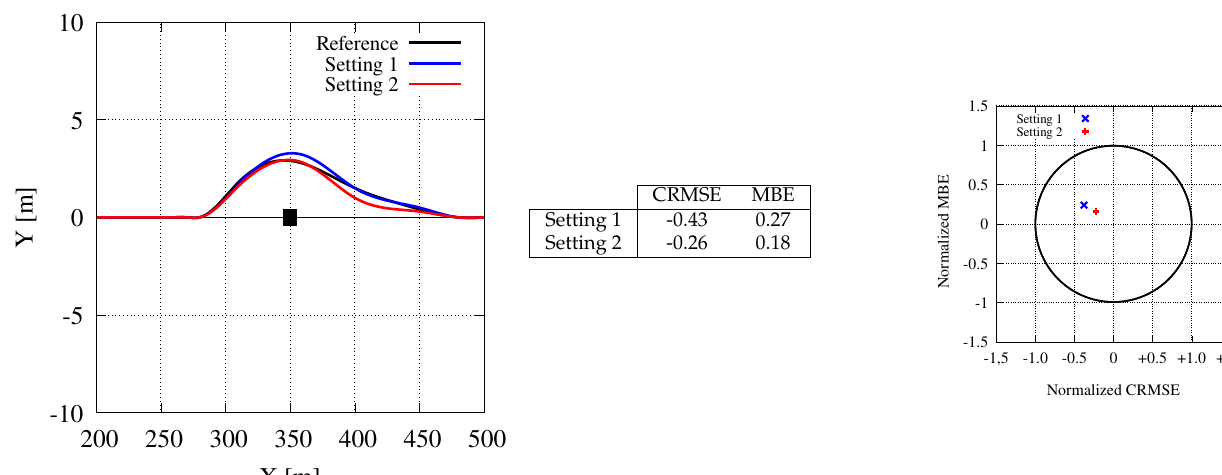
Figure 15. Generated paths for a scenario of a single obstacle avoidance. The CPU trajectory with the setting used by Cabodi et al. [7] (black color) is represented as a reference for the GPU ones (blue and read colors). The two GPU trajectories are computed with different settings.